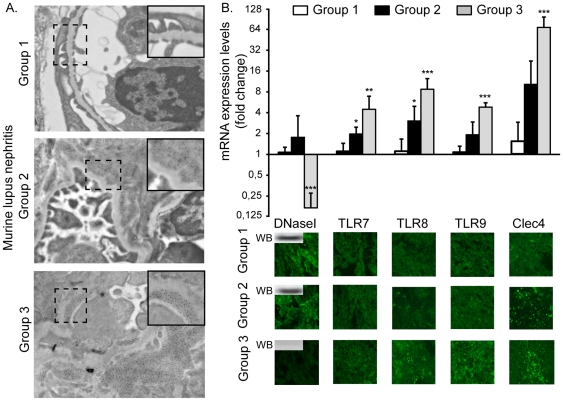
Renal expression of DNaseI, TLR and Clec4e in (NZBxNZW)F1 mice grouped according to glomerular location of EDS.The mice were sorted into 3 main groups according to kidney morphology (A); pre-nephritic mice (Group 1, no EDS (n = 6); mice with mesangial EDS deposits (Group 2 (n = 12)), or mice with EDS in GBM (Group 3 (n = 5)). Magnification ×40 k. In B, mRNA expression levels for renal DNaseI, TLR7–9 and for the Clec4e receptor with corresponding expression of proteins in kidneys of group 1–3 mice are demonstrated. DNaseI gene expression levels correlate inversely with TLR7–9 and Clec4e receptor expression levels, both with respect to transcription and translation of the genes in Group 3 of BW mice. For statistics, see Table 2. Inserts in the DNaseI immunofluorescence panels represent western blots of the DNaseI. An unpaired t-test was performed (*: p<0,05; ***: p<0,0001).